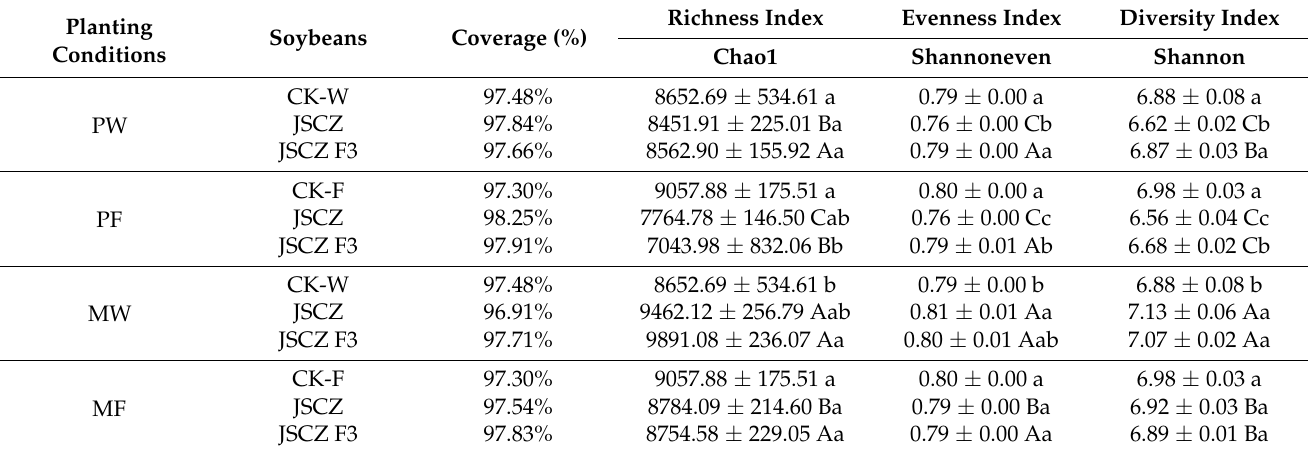
Table 3. Alpha diversity of rhizosphere soil of CK, JSCZ, and JSCZ F3.